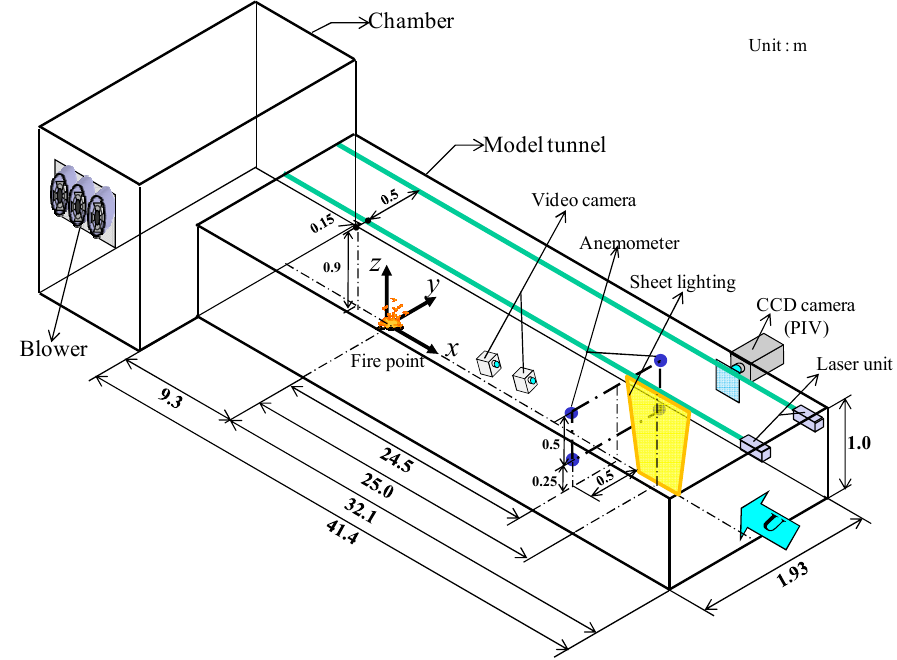
Fig. 1 Schematic diagram of the model